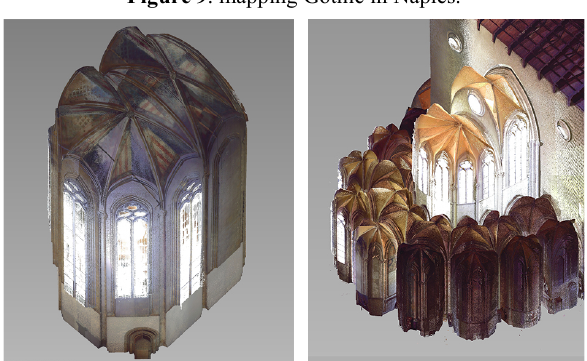
Figure 9 . mapping Gothic in Naples.